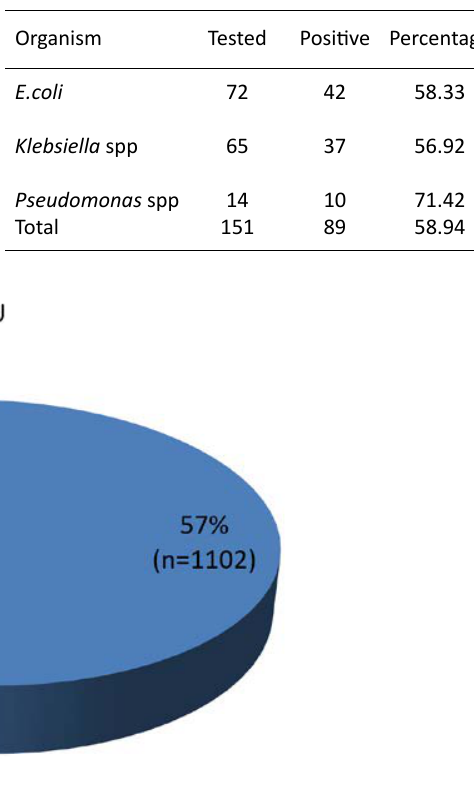
Table 4. Modified Carbapenemase Inactivation method